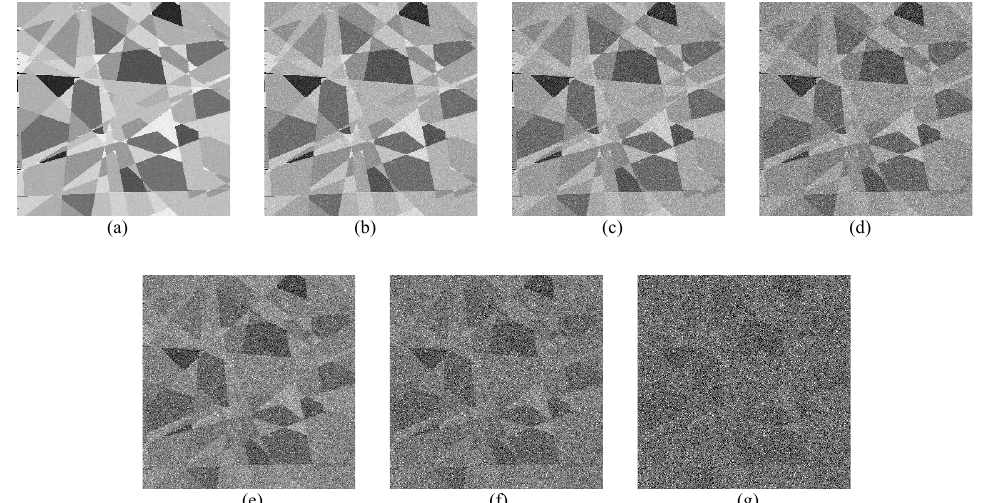
Fig.6 Simulated images from different mixture models